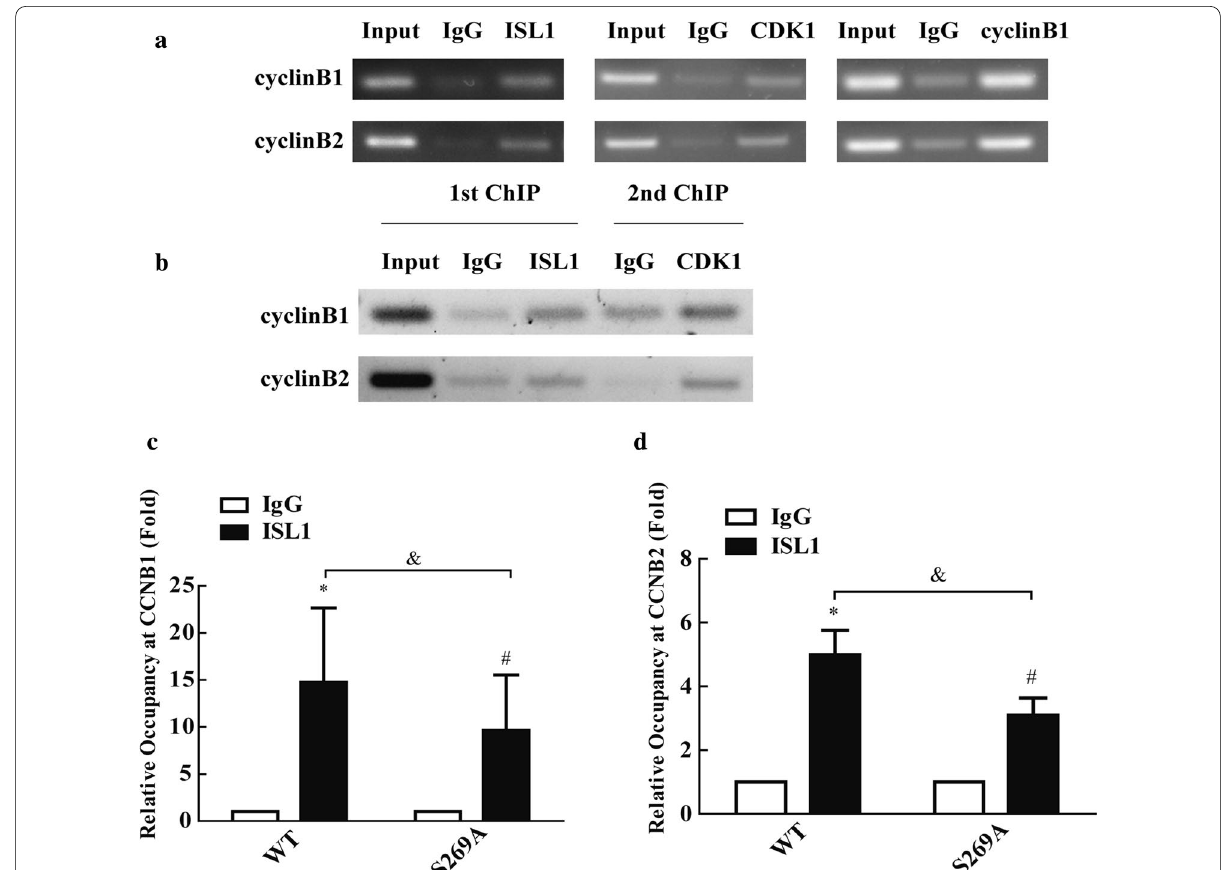
Fig. 4 Phosphorylated ISL1 showed improved localization on cyclinB1 and cyclinB2 promoters. a ChIP assay analysis and PCR gel electrophoresis analysis of ISL-1 recruitment to the cyclinB1 and cyclinB2 promoters in MGC803 cells. b ChIP-re-IP assay was performed with anti-ISL-1 or rabbit IgG antibodies and then with anti-CDK1 or IgG antibodies for immunoprecipitation using chromatin harvested from MGC803 cells. c , d Quantitative chromatin immunoprecipitation analysis of cyclinB1 and cyclinB2 promoters in MKN28 cell line transfected with control vector or expressing wild-type ISL1 or ISL1-S269A plasmids. Data are expressed as mean s. d. from three individual experiments. (* p < 0.05, WT vs. ± control, # p < 0.05, S269A vs. control, $ p < 0.05, WT vs.